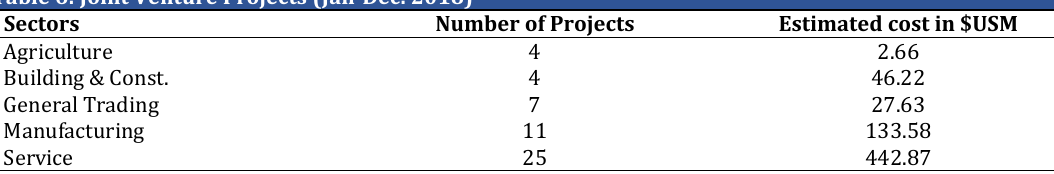
Table 6: Joint Venture Projects (Jan-Dec. 2018) Sectors